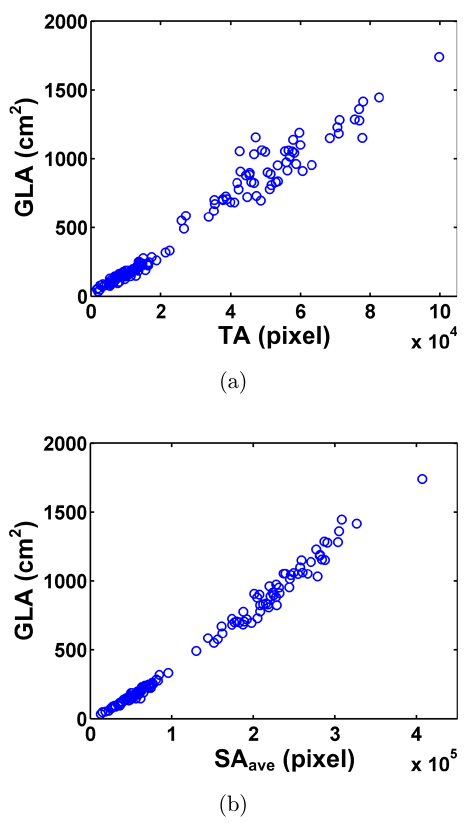
Fig. 3. Scatter plots of projected areas vs the actual total GLA. (a) top-view projected area (TA) vs GLA; (b) average side-view projected area (SA ave ) vs